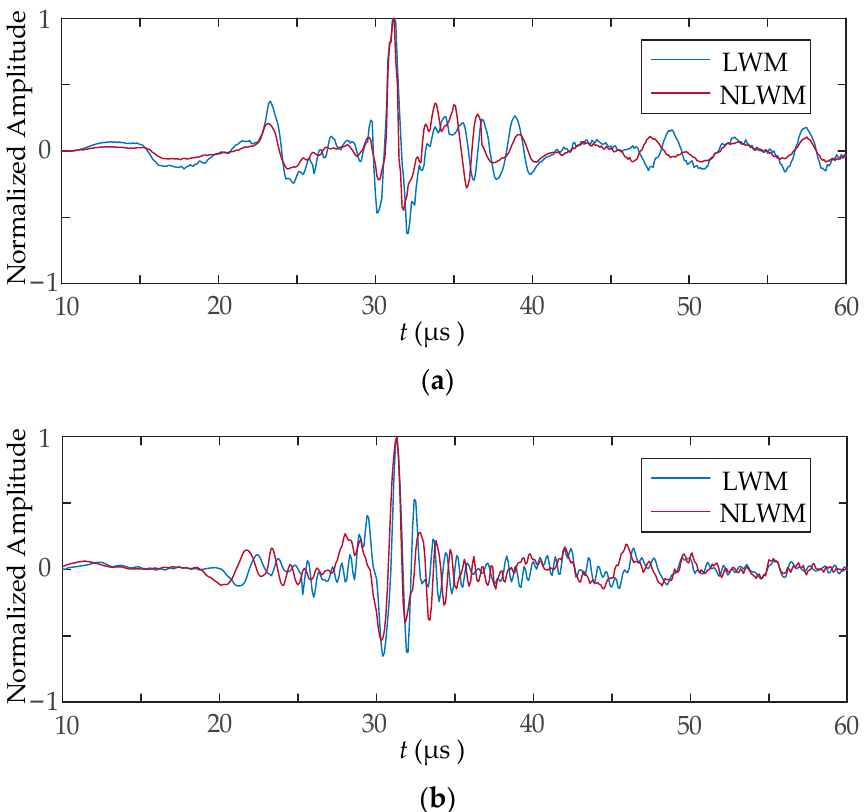
Figure 10. The current received signal: ( a ) case 1; ( b ) case 2.